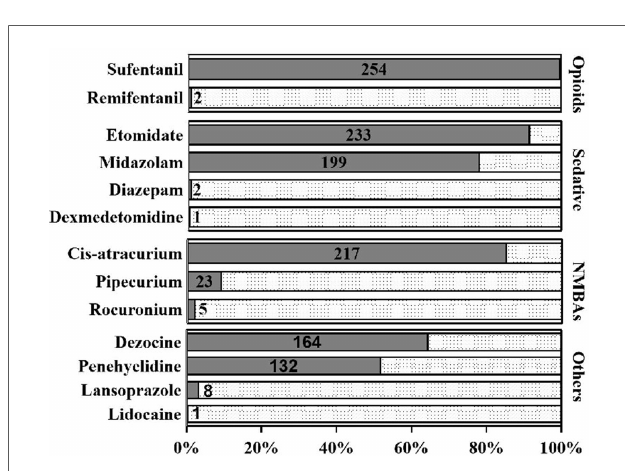
FIGURE 2 Frequency of anesthesia agents utilization during anesthesia induction period. Sufentanil (254/255, 99.6%), etomidate (233/255, 91.4%), and cisatracurium (217/255, 85.1%) were the most frequent anesthesia agents during induction period.